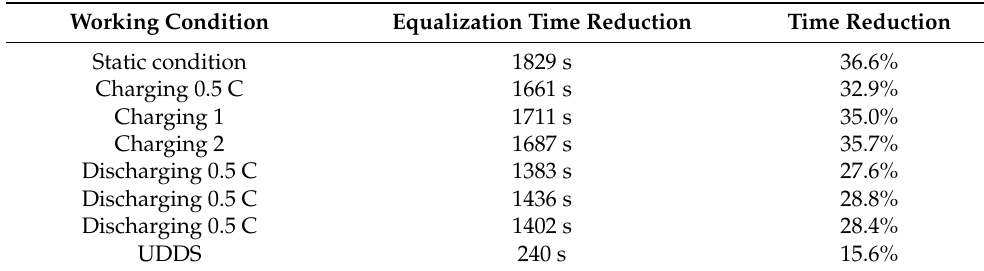
Figure 14. SOC response, under UDDS conditions, of the two schemes. Table 1. Summary of performance comparison of two balancing